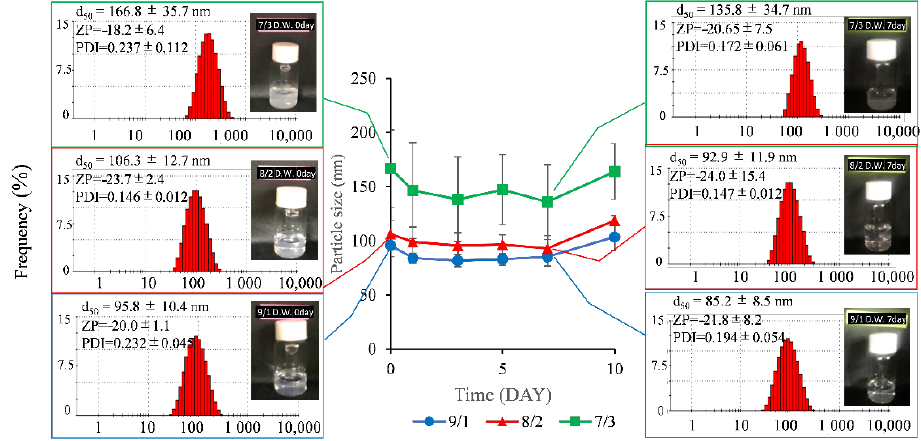
Figure 3. Changes in particle size and zeta potential of nanoparticles of Sol/ASC-DP at mixing ratios of 9/1, 8/2, and 7/3 after storage at 25 °C from day 0 to day 10 in distilled water. Zeta potential is presented as the mean ± S.D. ( n = 3).